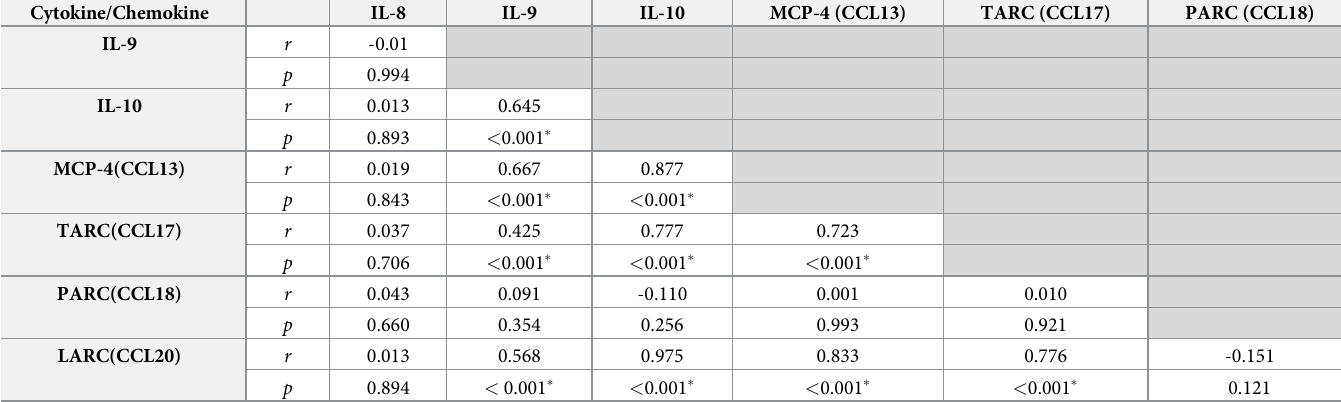
Table 10. Pearson’s correlations of cytokine and chemokine levels observed in AE patients are shown. r = Pearson’s r, p = significance level with � considered significant.